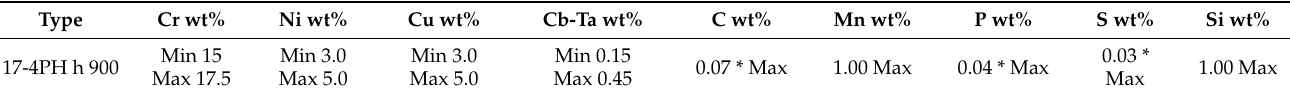
Table 1. Elemental composition of 17-4PH h 900 martensitic surgical steel.